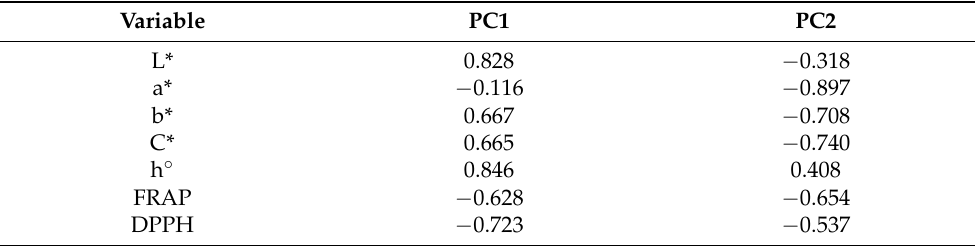
Table 3. Correlations between the principal components and the original